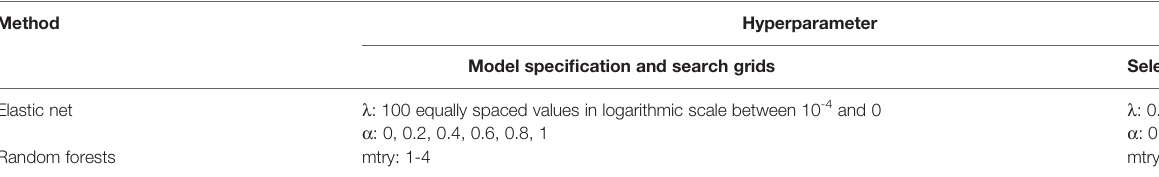
TABLE 4 | Machine learning model speci fi cs.